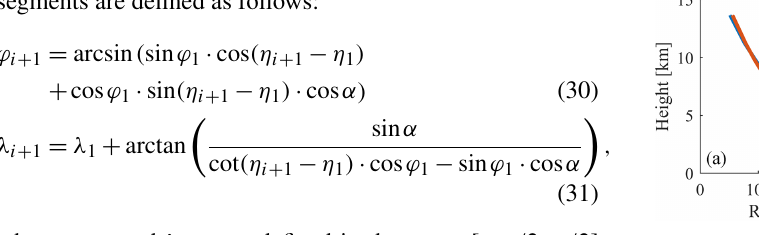
Figure 2. Ray-traced signal path differences (b) caused by differ- ences in the a priori refractivity field (a) .